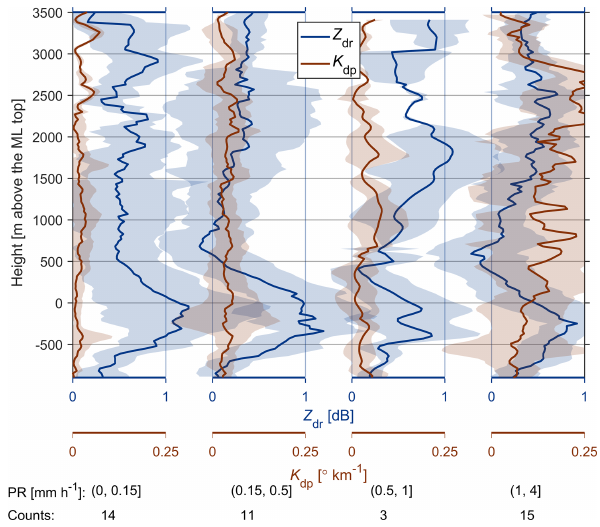
Figure 10. Normalized Z dr and K dp profiles observed by FMI C- band radar with RHI scanning. Number of RHI profiles is presented at the bottom. The ML top (as retrieved from X-SACR observa- tions) is used as the reference height in the vertical